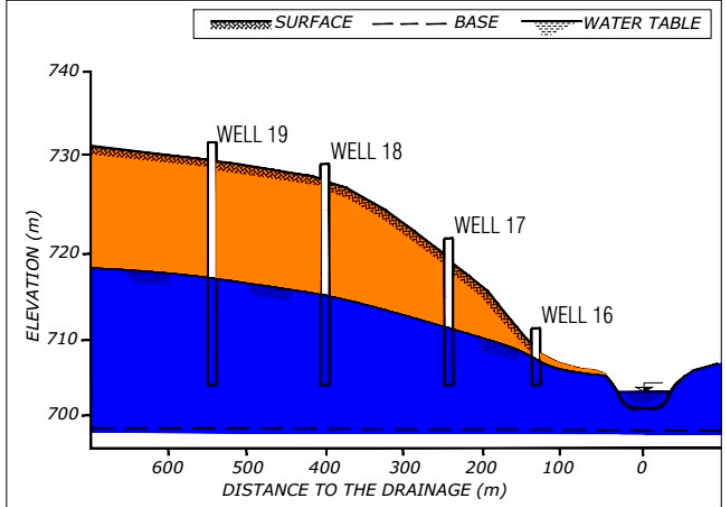
Figure 2. Schematic profile of the monitoring wells in the study area.